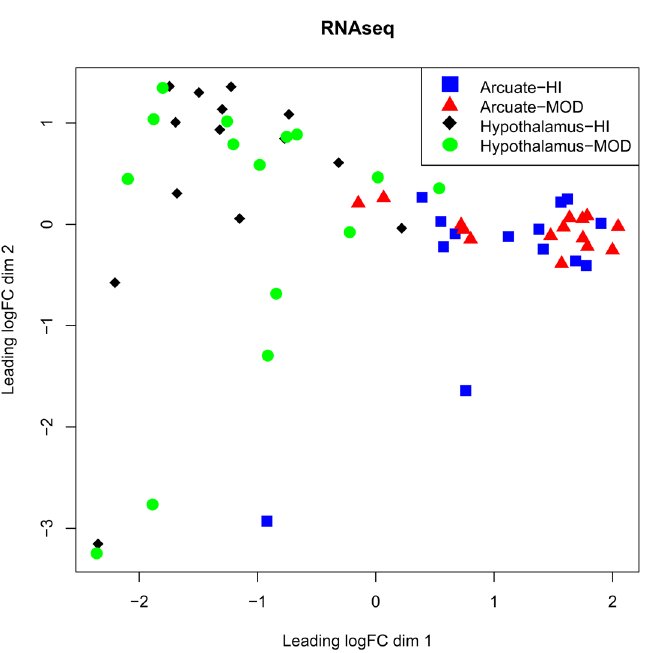
Figure 2. Multi-dimensional scaling plots for arcuate nucleus and the remainder of the hypothalamus of heifer calves on high (HI) vs moderate planes (MOD) of